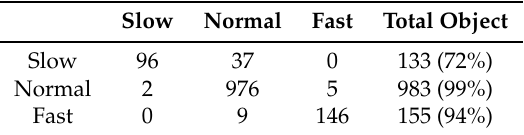
Table 6. Result of the classification of the speed-based search.